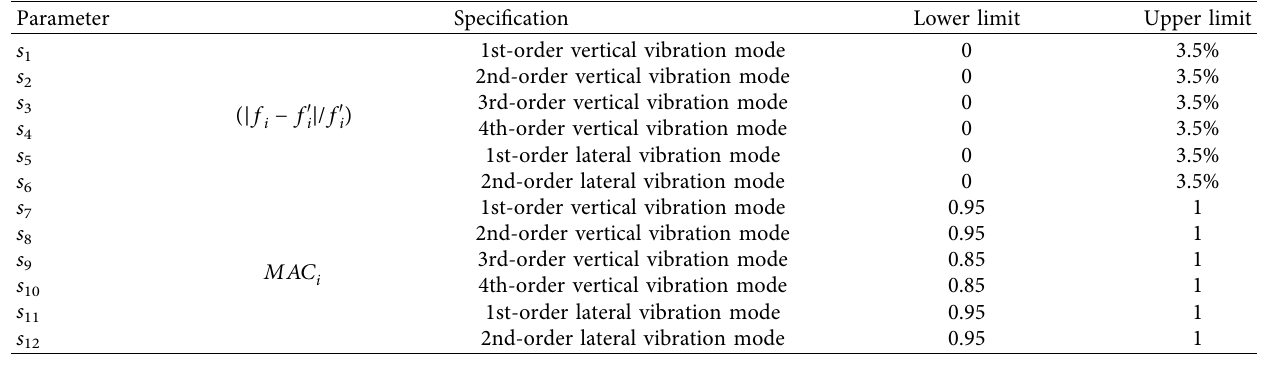
Table 4: State variables.